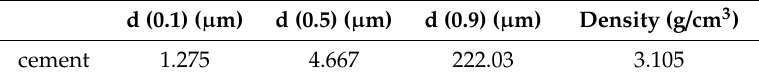
Table 2. Granulometry and density (g / cm 3 ) of cement